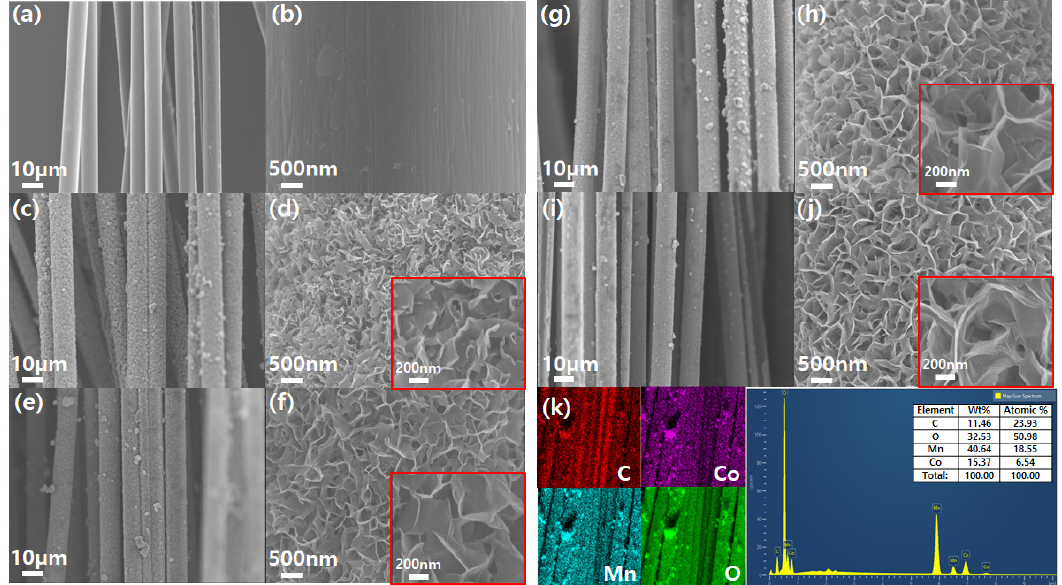
Figure 1. FE-SEM images of pure polyimide-based carbon fibers (PICFs) ( a , b ), CoMnO 2 @PICF-1 ( c , d ),